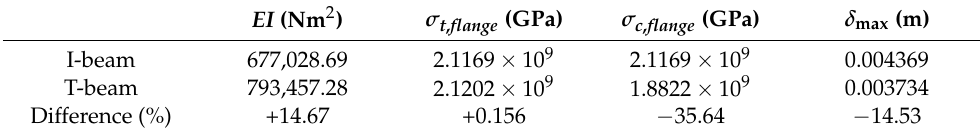
Table 1. Comparison of effective stiffness, stress, and deflection of